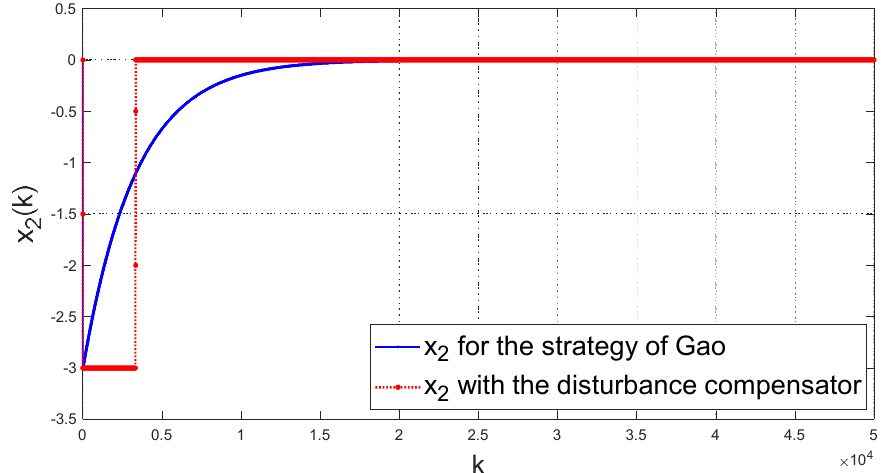
Figure 9. x 2 ( k ) for both control strategies.